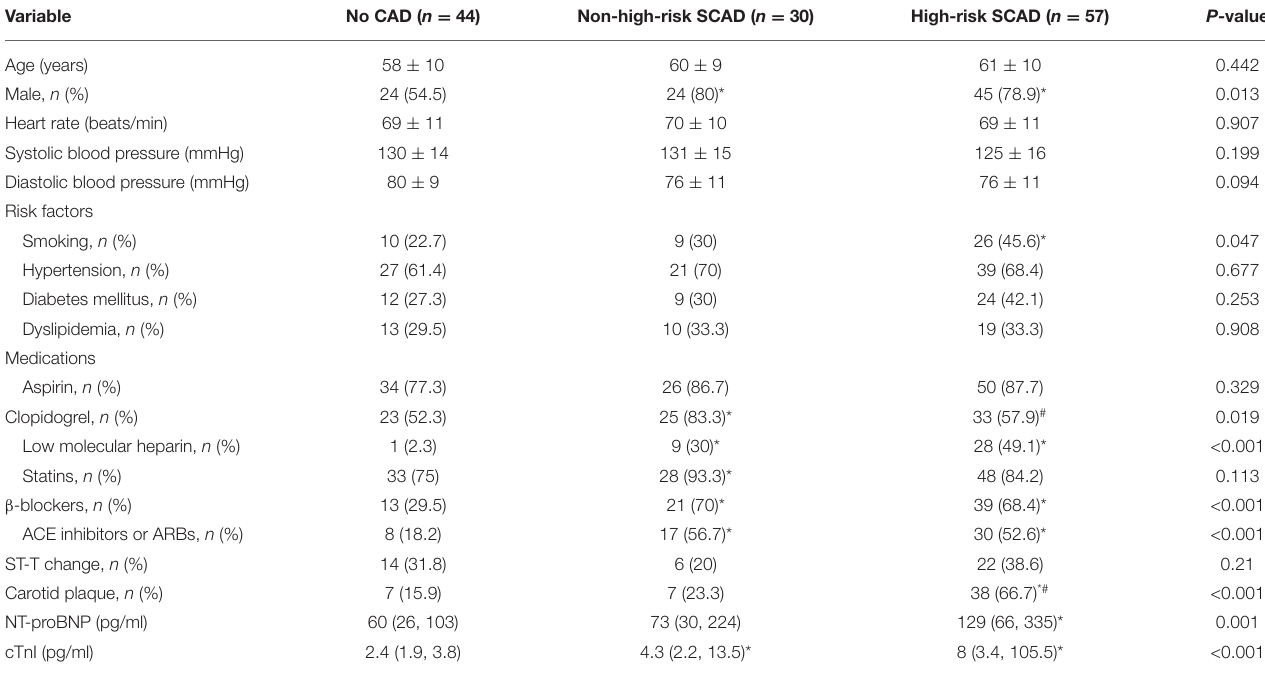
TABLE 1 | Baseline clinical